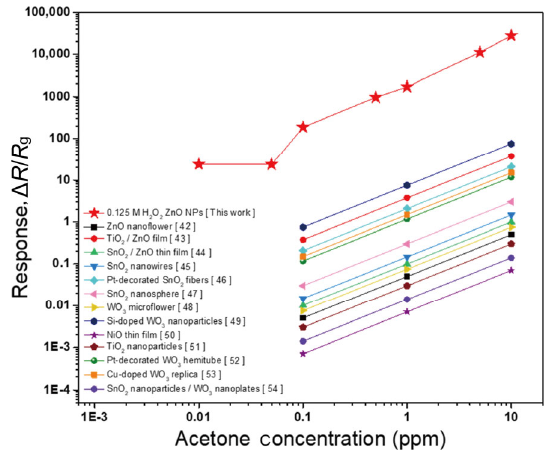
Fig. 9 Comparison of sensing response of 0.125 M H 2 O 2 treated/annealed ZnO NPs to previously reported MOS- based gas sensors for various concentrations of acetone.